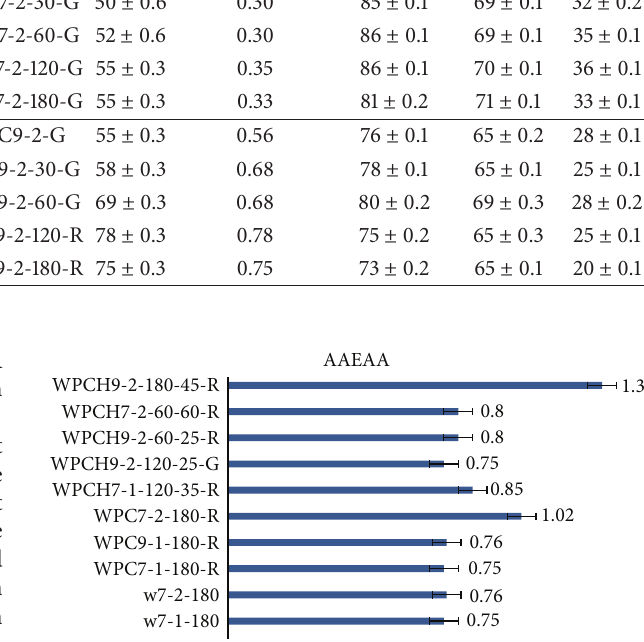
Figure 3: AAEAA of representative glycosylated products from wheymilkinindividualexperimentswithriboseandglucoseat50 ∘ C and variations of pH 7 and pH